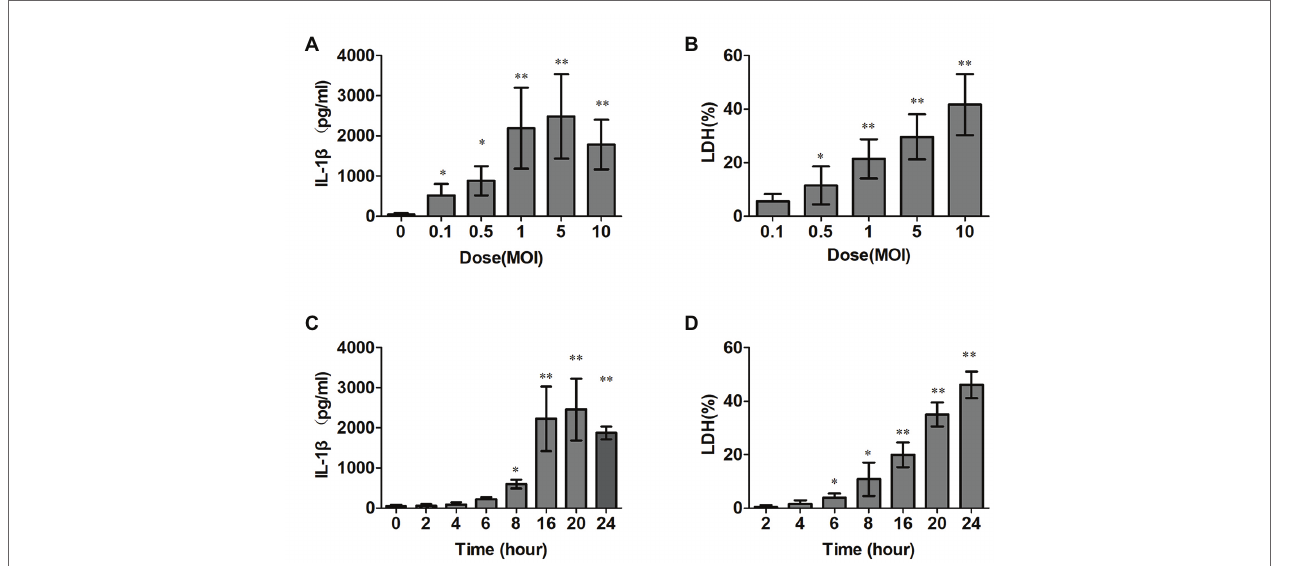
FIGURE 1 | Streptococcus suis serotype 2 (SS2) trigged interleukin (IL)-1 β production and induced cytotoxicity in vitro . (A,B) Bone marrow derived macrophages (BMDMs; 1 × 10 6 cells/ml) were infected with SS2. The supernatants were harvested at different time points after infection. The IL-1 β release was measured with ELISA (A) , and lactate dehydrogenase (LDH) leakage was detected using the CytoTox96® non-radioactive cytotoxicity kit (B) . (C,D) BMDMs were infected with SS2 at different doses, and the supernatants were harvested for IL-1 β (C) and LDH detections (D) The data shown have the means ± standard deviations from three independent experiments. * p < 0.05; ** p <